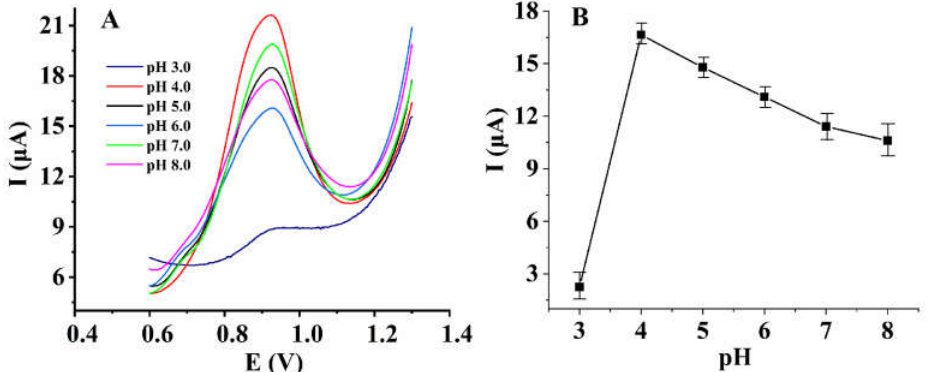
Figure 6. Differential pulse voltammograms of 1 mM nitrite on PTP − AgNP/PGEs in 0.1 M PB with differing pH values ( A ), and the influence of the pH value of the PB solution on the oxidation peak current of nitrite ( B ).